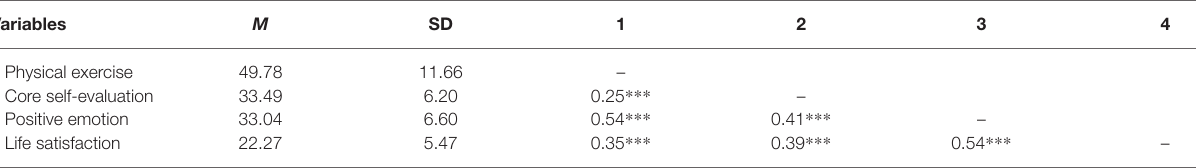
TABLE 1 | Descriptive statistics and interrelations among all observed